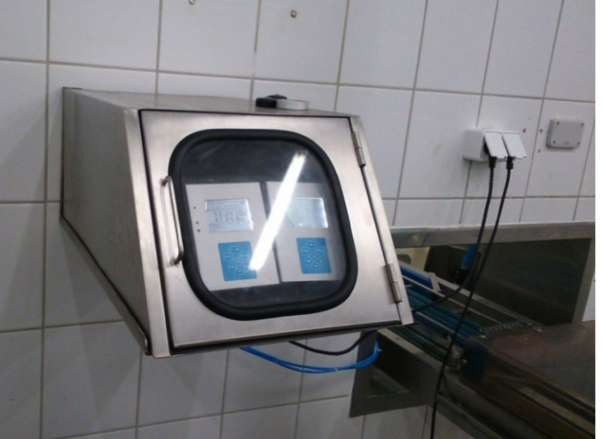
Figure 8. Continuous mode analyzer PA7 ® , reprinted with permission from WITT